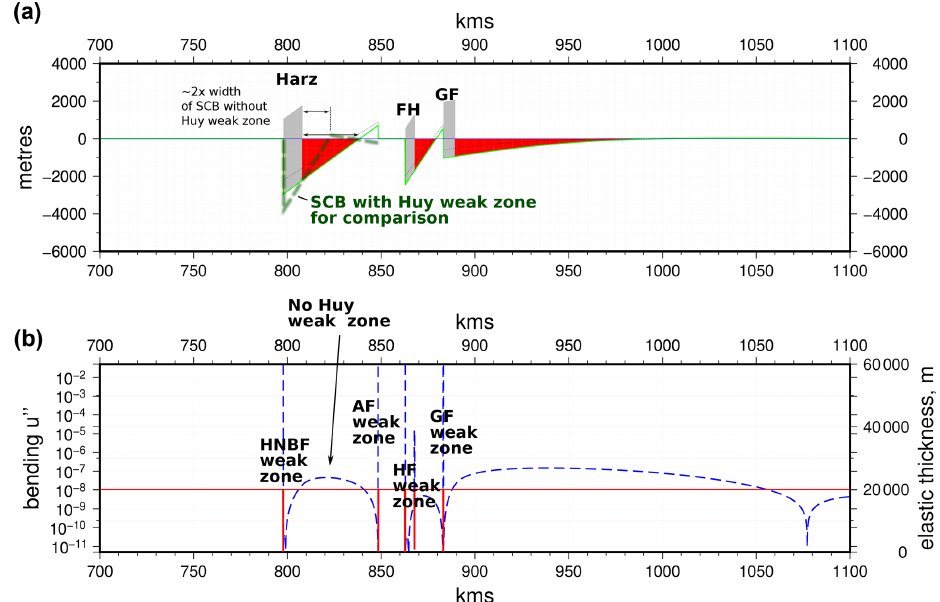
Figure 8. Flexure model (same as Fig. 7 but not including the Huy weak zone) to simulate the situation in the western part of the basin. The basin width of the model including the Huy weak zone is shown for comparison (dark green dashed line). Abbreviations: HNBF – Harz Northern Boundary Fault; AF – Allertal Fault; HF – Haldensleben Fault; GF – Gardelegen Fault; SCB – Subhercynian Cretaceous